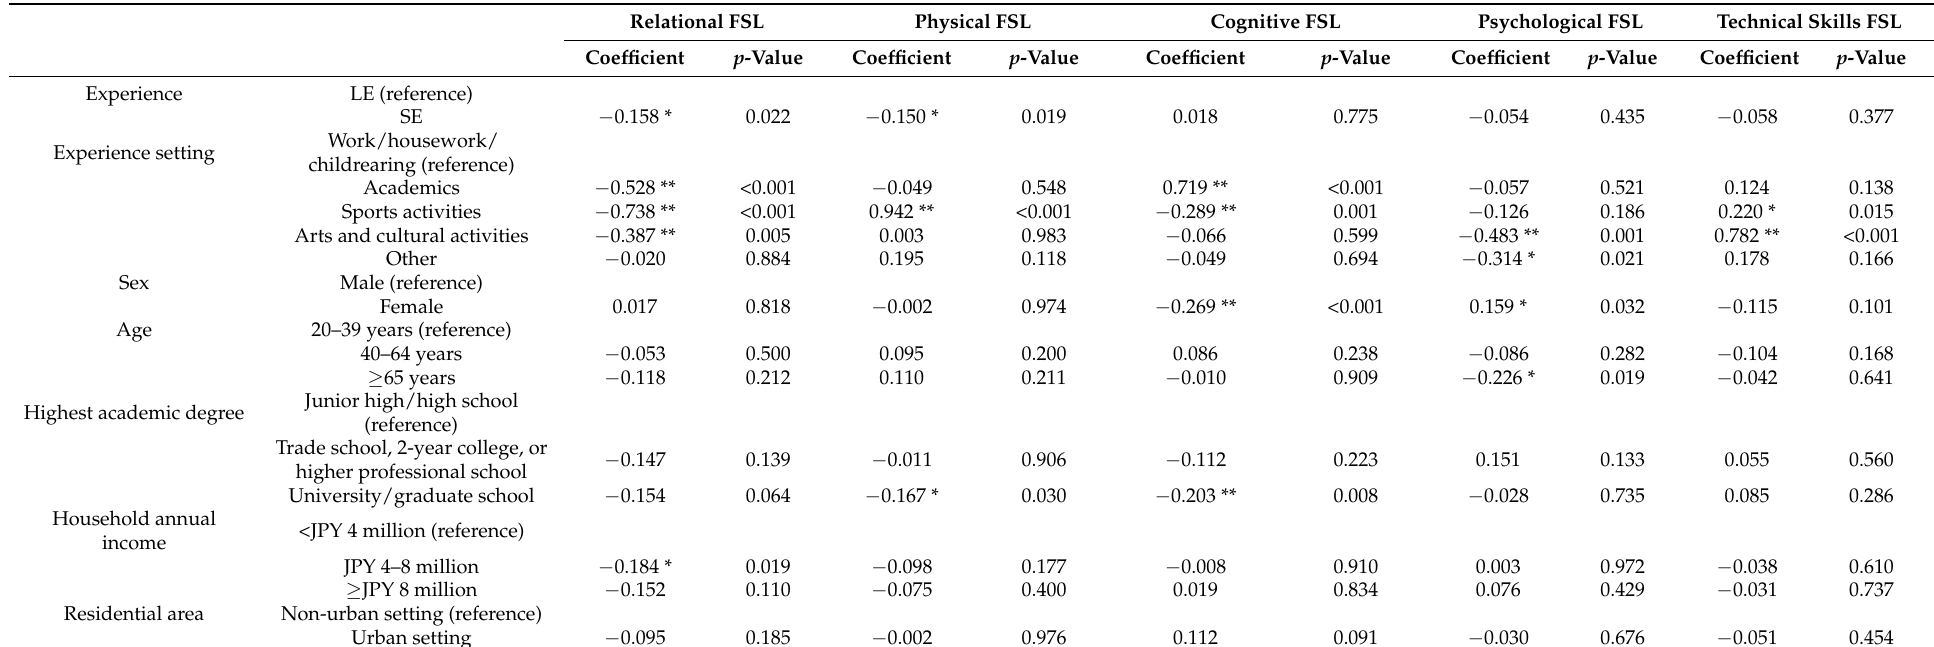
Table 5. Respondent characteristics as associated with their experience with limits and